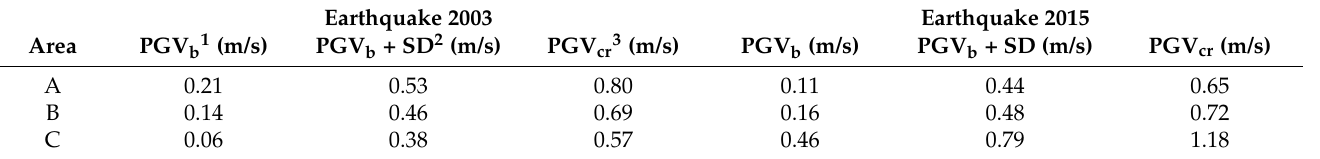
Table 5. Peak ground velocity values for each area and